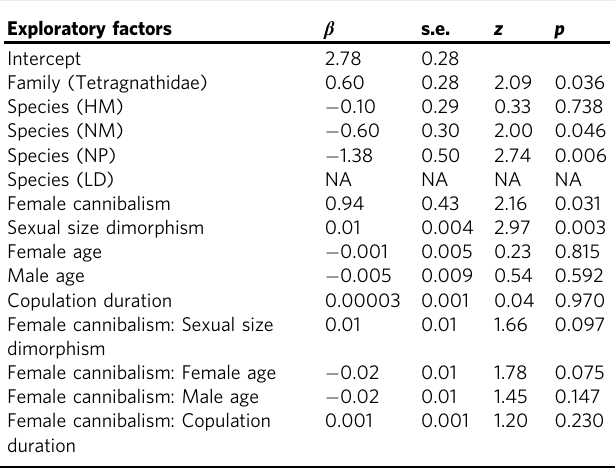
Table 3 The best fi tting GLM model including seven predictors alone (family, species, presence of sexual cannibalism, copulation duction, sexual size dimorphism, female age, male age) and four two-way interactions to predict the percentage of sperm transferred to the female spermatheca.